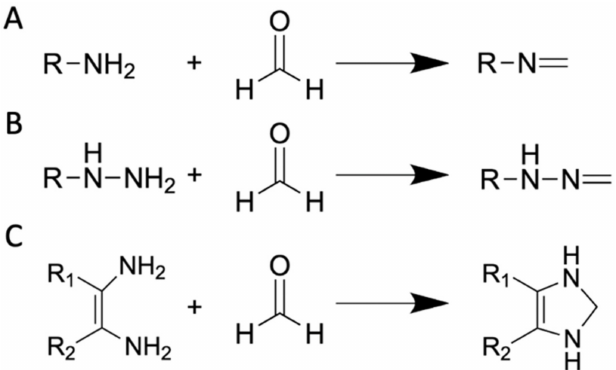
Figure 8. Schematic representation of the reactions for FA detection based on ( A ) formimine-, ( B ) hydrazine- and ( C ) diamine-containing probes. R denotes fluorophore-containing